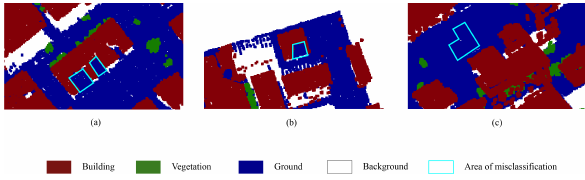
Figure 6. Misclassification cases which recognized roof as ground points in Toronto